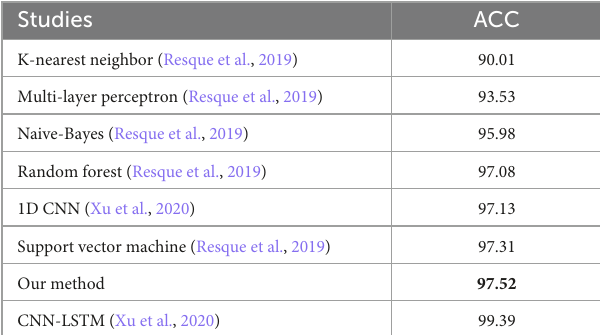
TABLE 7 Comparison of proposed approach with other